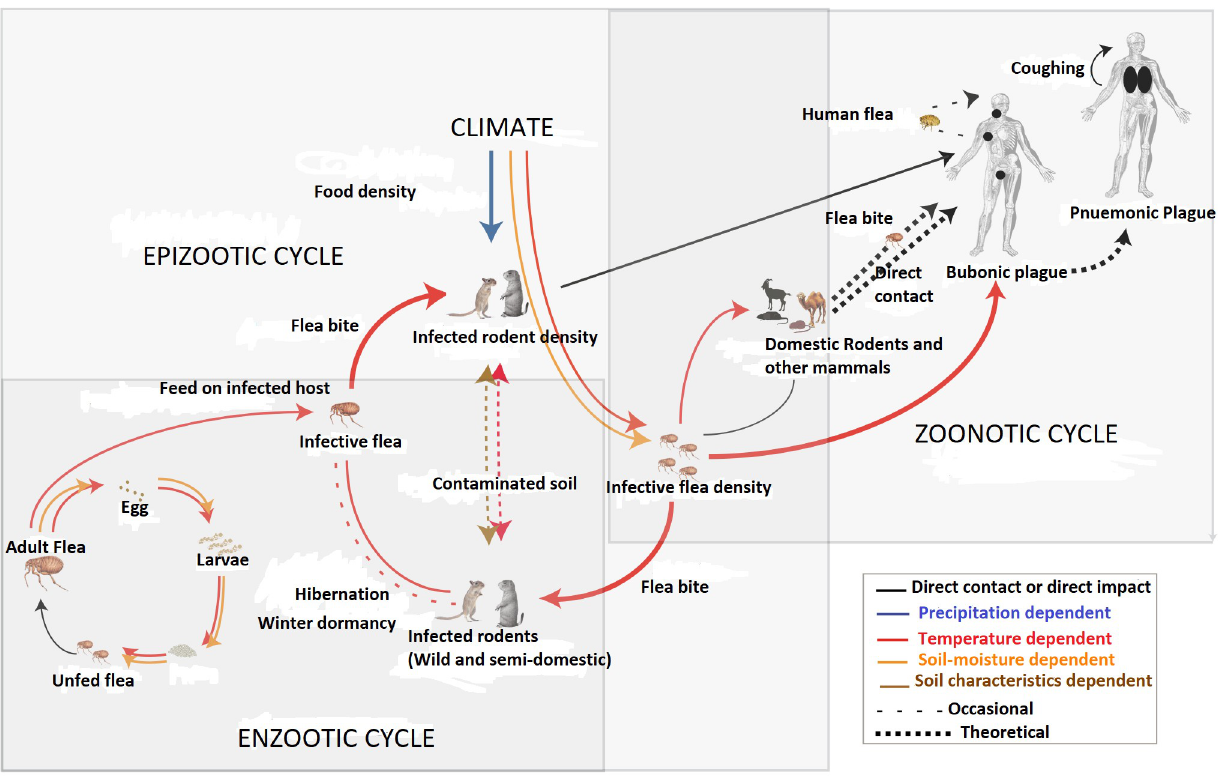
Fig 1. Transmission cycle of Y . pestis in a plague-endemic community. This figure was originally published by Ben Ari et al. [37] which was made available under the Creative Commons CC0 public domain dedication. Under favourable environmental conditions, populations of rodent species that are very susceptible to plague infection ( T . leucogaster and Mastomys coucha ) increase to high levels [38]. If these population increases occur in an area where there is a quiescent plague focus, the plague may break out in the susceptible rodent population. In plague-endemic areas, this population increase is crucial in plague transmission because a large number of mice and rats correspond to a large number of fleas [38]. Plague kills the susceptible rodents, and their infected fleas leave the carcass and seek new hosts, thereby spreading the infection rapidly throughout areas of high population.